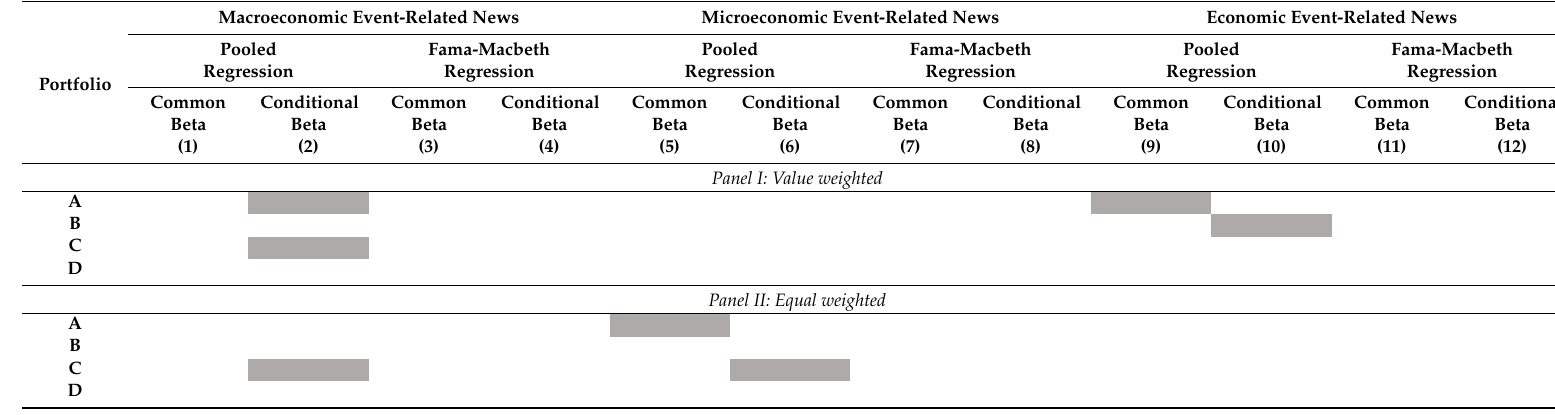
Table 5. Conclusive results of other news about economic